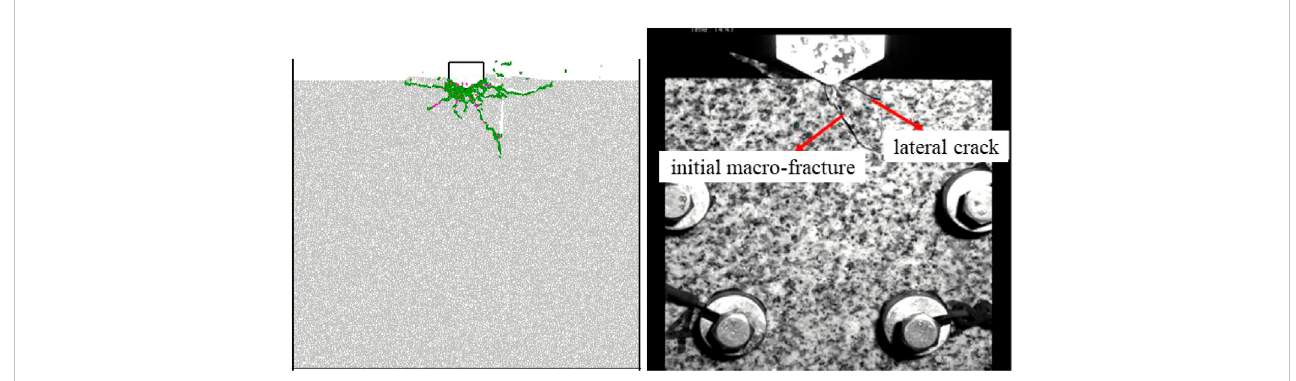
FIGURE 12 Rock sample destruction diagram (L=20 mm H=30